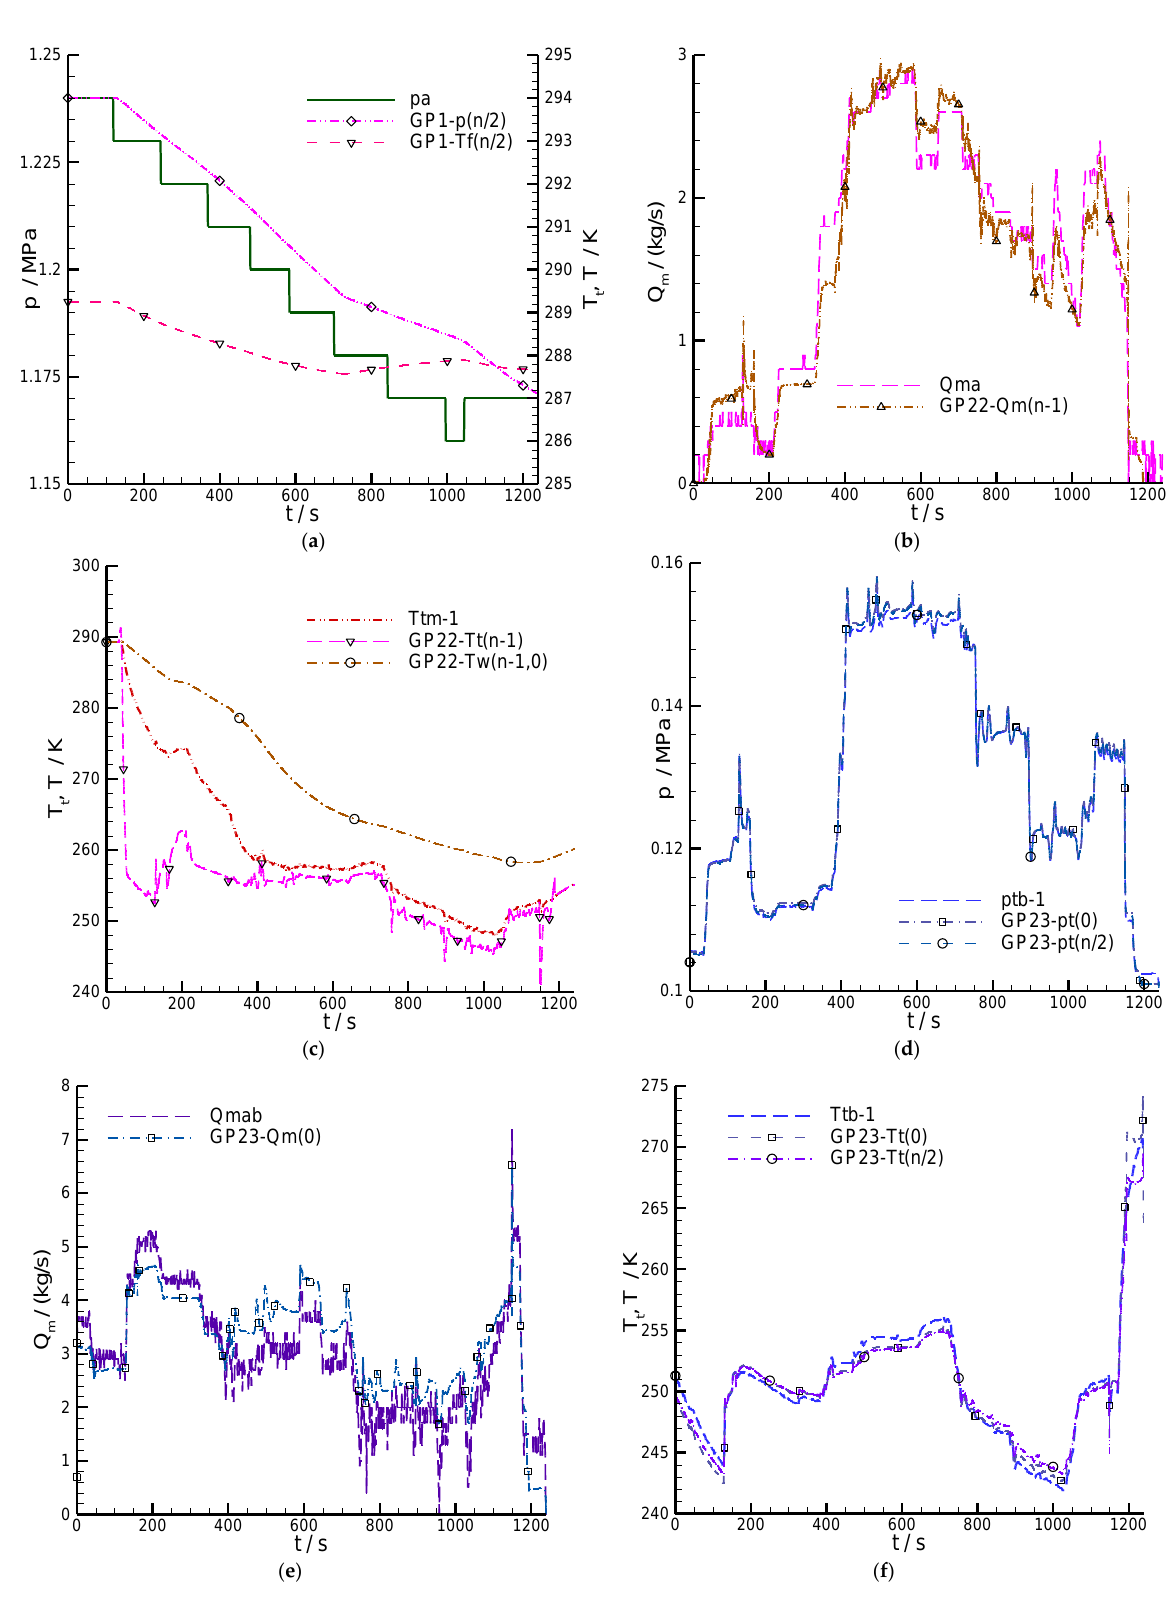
Figure 10. Comparison of simulation results with experimental measurements on the 1240 s low-temperature condition. ( a ) Pressure of normal-temperature air at inflow measurement section. ( b ) Mass flow rate at engine inlet measurement section. ( c ) Total temperature at engine inlet measurement section. ( d ) Total pressure at bypass measurement section. ( e ) Mass flow rate at bypass measurement section. ( f ) Total temperature at bypass measurement section.